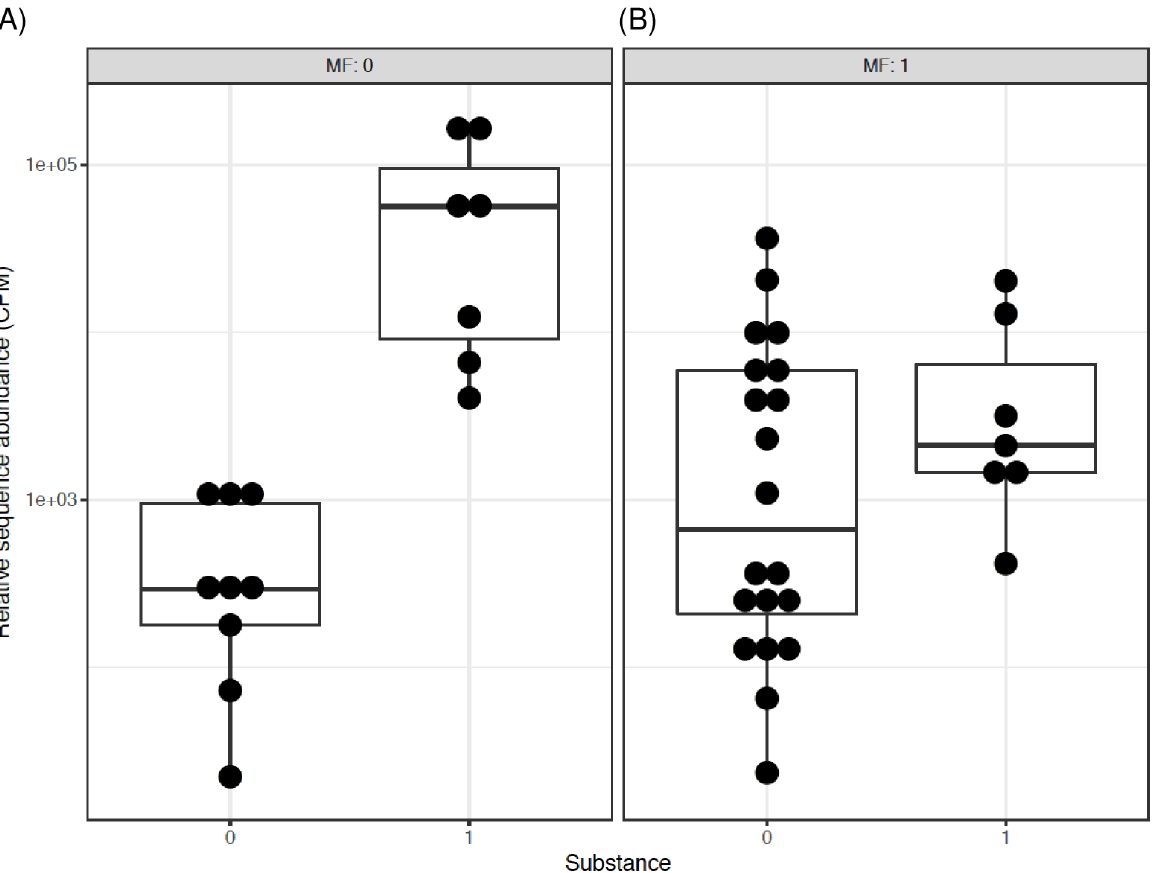
Fig 5. The interactive influence of metformin on Bifidobacterium genus in men with T2D and using or not using opioids. Data are pair-wise comparisons for the relative sequence abundance of Bifidobacterium . The differential subgroup analysis was done using edgeR, the false discovery rate (FDR) adjusted p values (q values) were calculated using the Benjamini-Hochberg FDR correction. Abbreviations: 0/1 = factor absent/present. CPM = count per million, MF = metformin, Substance = opioids. (A) 6.74 log2 fold increase in Bifidobacterium in opioid users vs. non-users when both groups are not taking metformin (q = 2.2 x 10 −8 ). (B) No difference between opioid users vs. non-users when both groups are taking